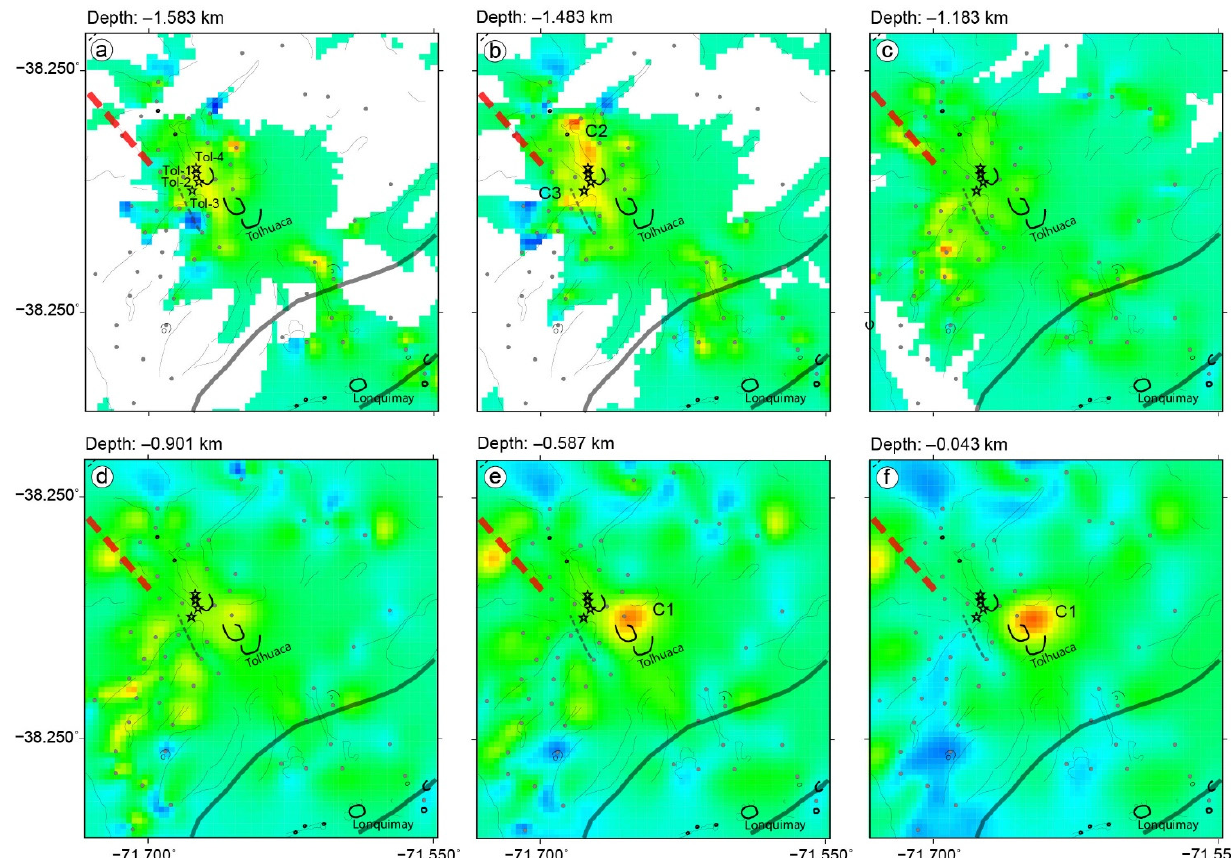
Figure 6. Plan view of the 3D model obtained from inversion presented for six different depths showing the relationship between conductive anomalies spatially distributed near the surface and geothermal surface manifestations and volcanic lineaments shown in Figure 2. Gray dots represent MT sites. Stars represent wells.